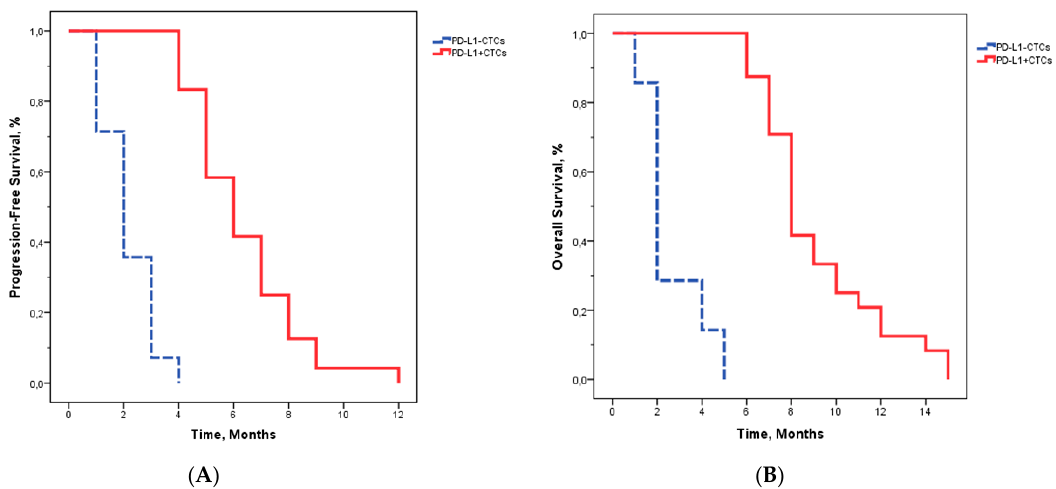
Figure 3. Kaplan–Meier plots of progression-free survival and overall survival according to PD-L1 expression on CTCs prior to regorafenib. ( A ): Progression-free survival. ( B ): Overall survival.